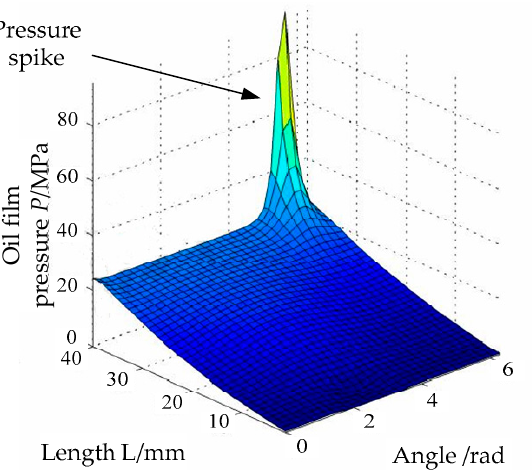
Figure 8. The figure shows pressure spike of plunger auxiliary oil film.